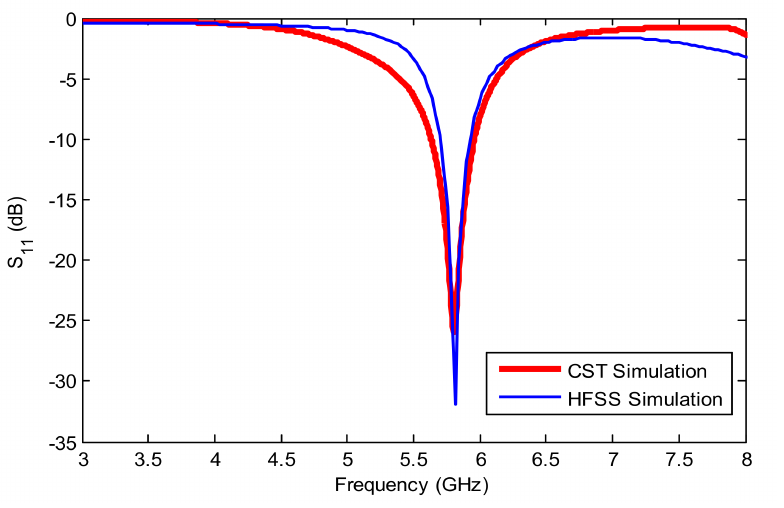
Figure 6. Simulated return loss of the proposed patch antenna without the thin film for the HFSS and CST simulators.